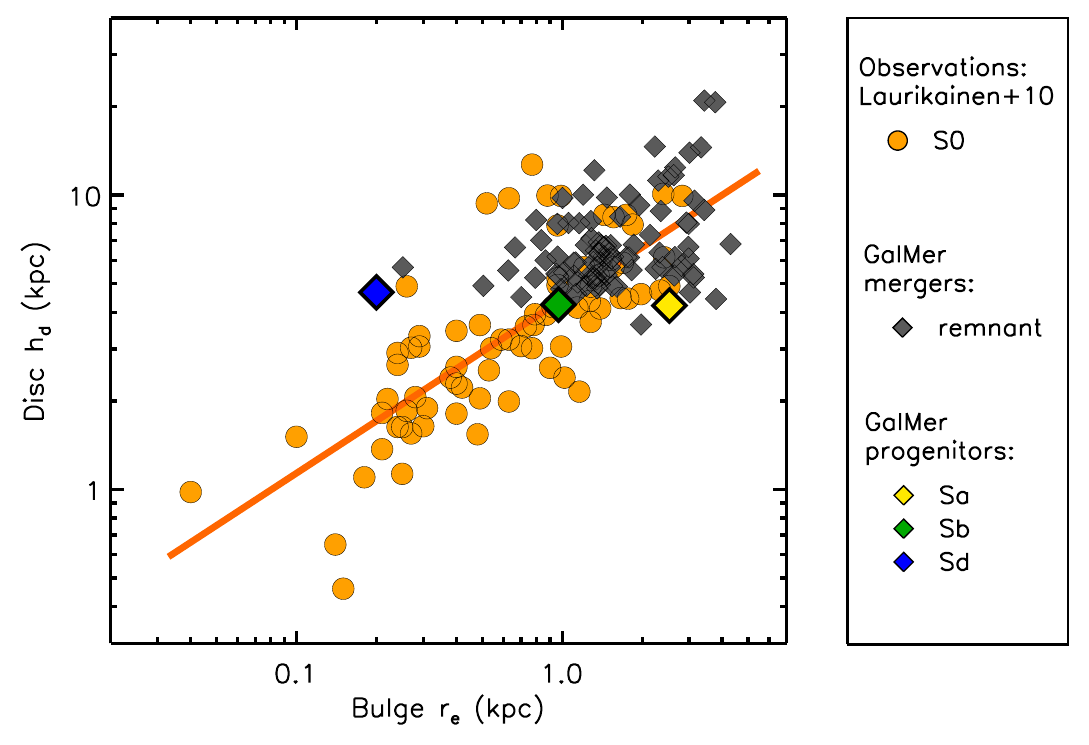
Figure 2. Highlight from Figure 5 in Querejeta et al. [1], making it clear how the major merger remnants that we have studied ( black diamonds ) overlap the observations of S0s ( orange ) from Laurikainen et al. [5]; observational spirals are not shown here for clarity purposes, but they display a larger scatter than